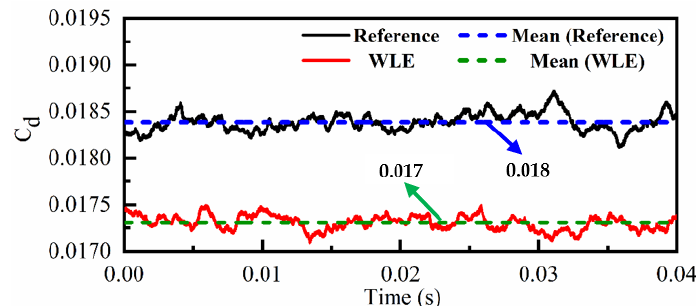
Figure 13. Comparison of the drag coefficient.